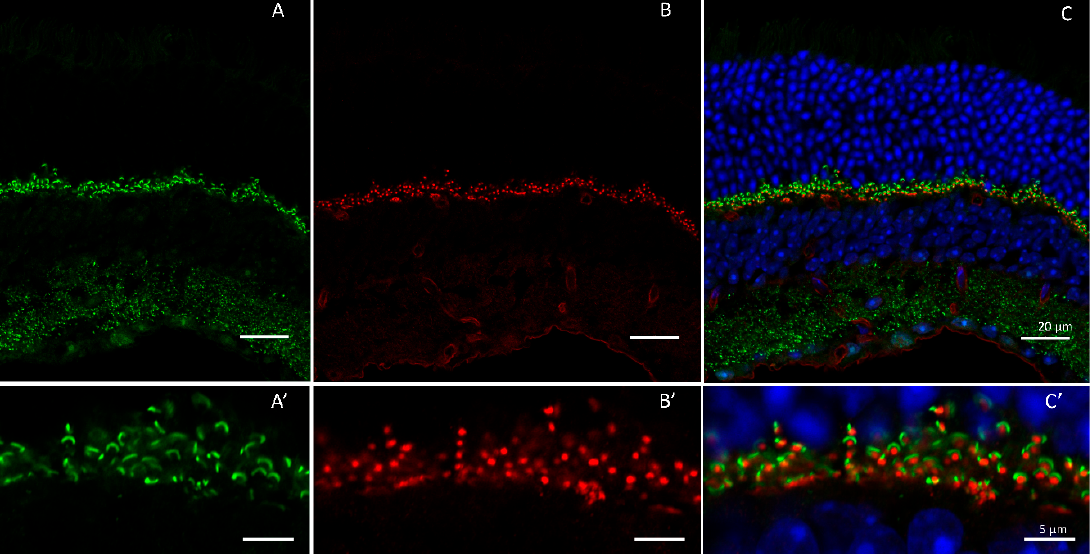
Figure 7. Dystroglycan is localized to the outer plexiform layer of the retina. Shown is antibody staining of an adult wildtype mouse retina labeled with ( A ) Ribeye (green) and ( B ) dystroglycan